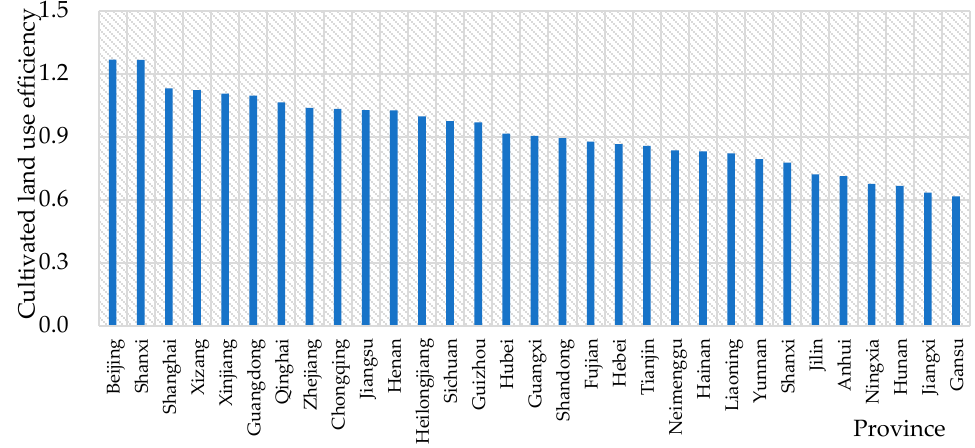
Figure 2. Cultivated land use efficiency in each province.